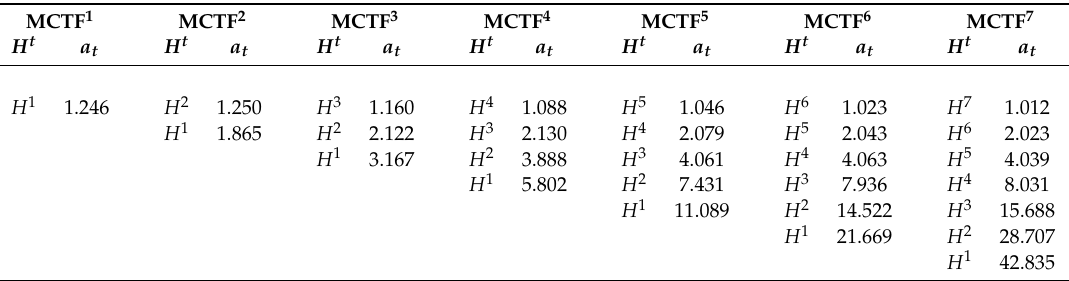
Table 1. L 2 -norm (energy) of the MCTF basis functions for the temporal sub-bands, expressed as attenuation